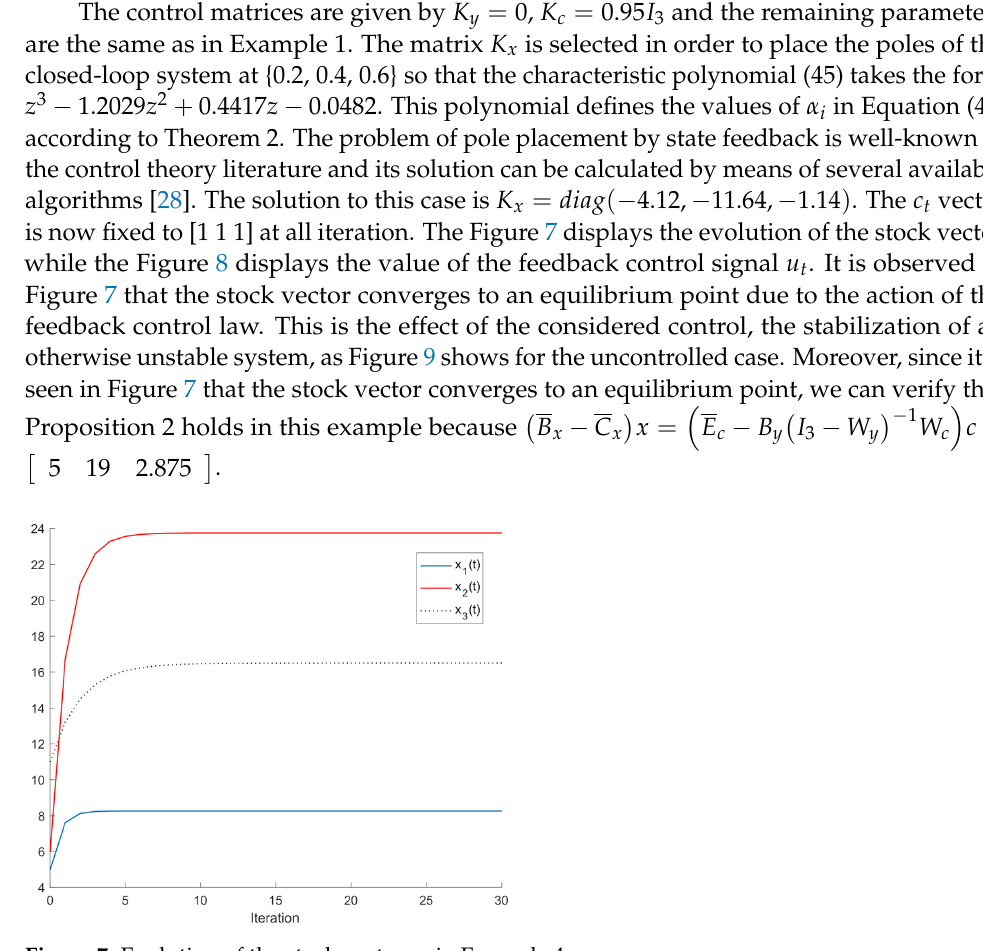
Figure 7. Evolution of the stock vector x t in Example 4.